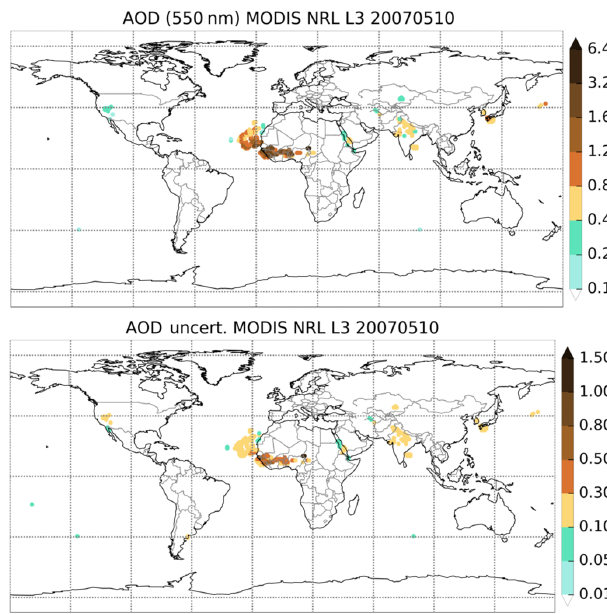
Figure 3. Aerosol optical depth (top) and its associated observation error (bottom) for 10 May 2007 for the MODIS Deep Blue Col- lection 6 Level 3 product after the application of a filter for dust- dominated